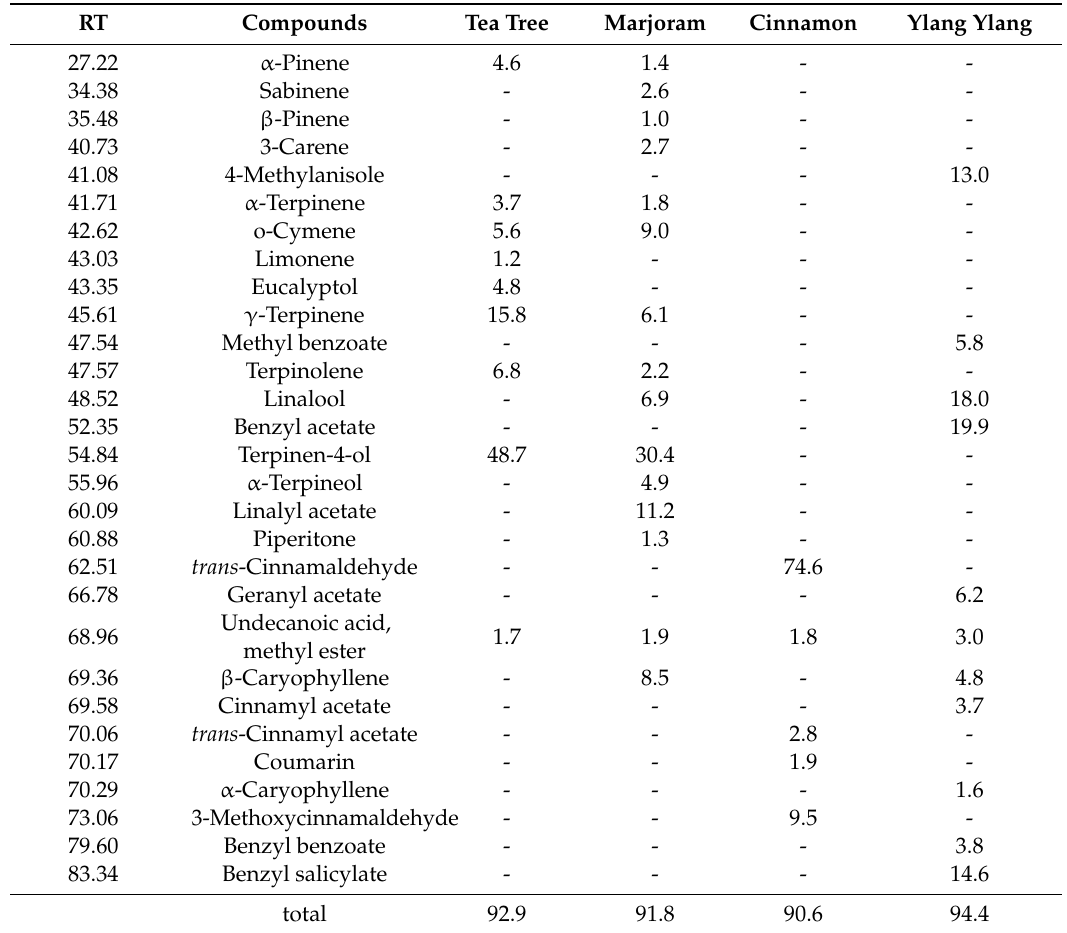
Table 3. Chemical constituents of four most active essential